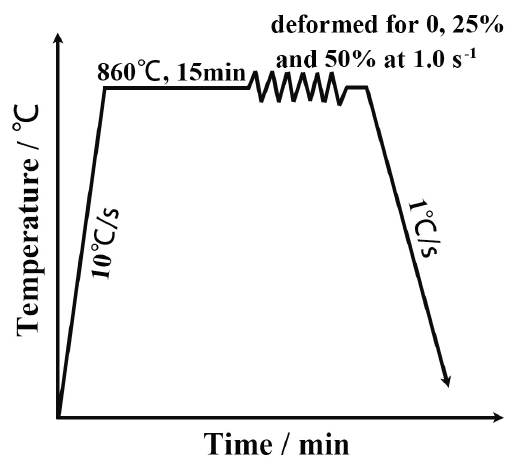
Figure 2. The illustration of the experimental